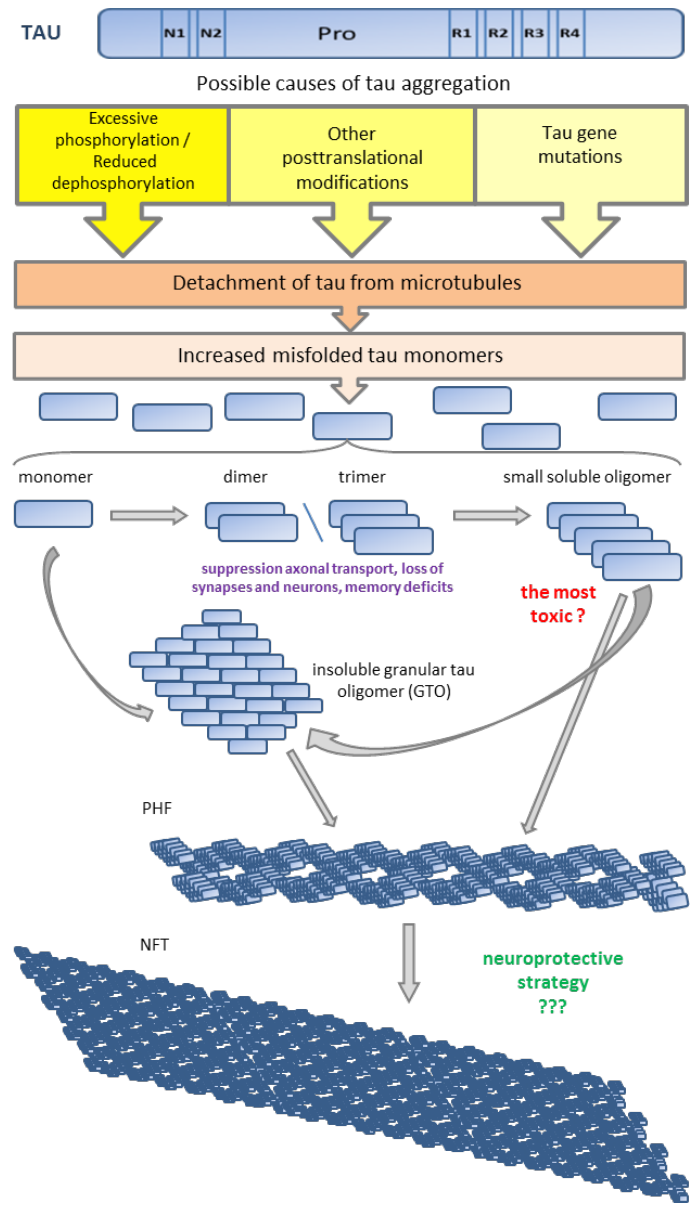
Figure 2. Proposed sequence of stages leading to tau pathology. Detachment of tau from microtubules increases amount of misfolded tau monomers. Monomers aggregate into small soluble tau oligomers. Small soluble tau oligomers and tau monomers can proceed to form granular tau oligomers (GTOs). Probably both, small oligomers and GTOs form paired helical filaments (PHFs) but GTOs are considered to be the main precursors of PHFs. Subsequently PHFs spontaneously aggregate into neurofibrillary tangles